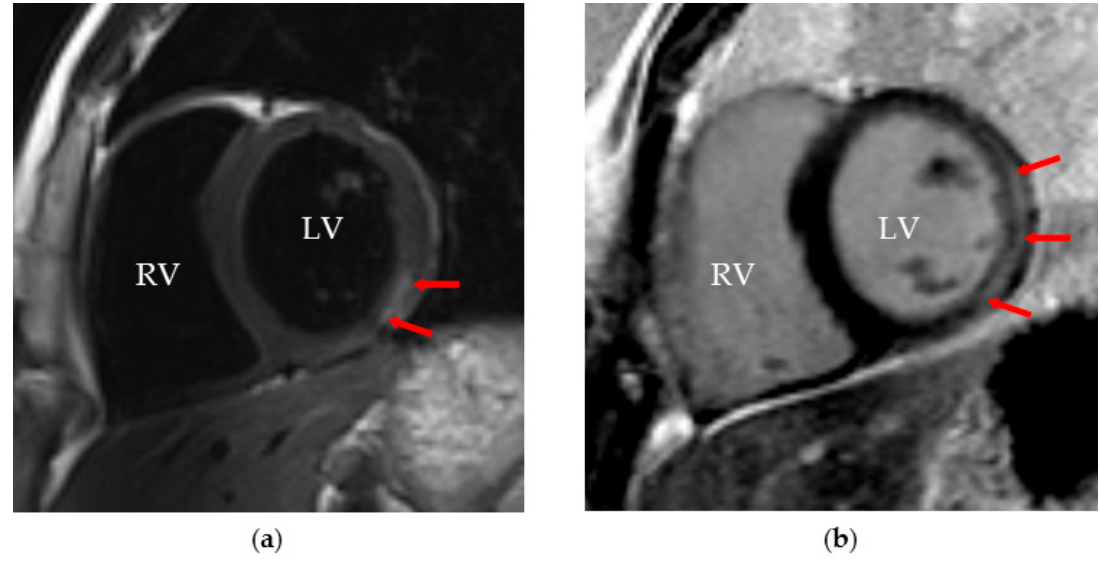
Figure 2. A 15-year-old boy with Epstein–Barr virus myocarditis: ( a ) a short-axis T2-weighted image demonstrating focal myocardial oedema (red arrows); and ( b ) a short-axis T1-weighted late gadolinium enhancement image (red arrows). RV, right ventricle; LV, left